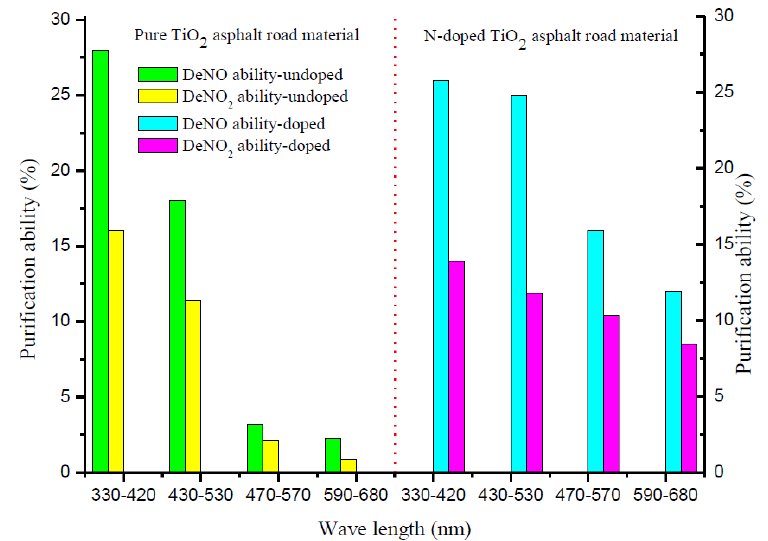
Figure 16. Degradation of NO and NO 2 on neat titania and N-doped titania coated asphalt under different irradiation conditions. (Reprinted/adapted with permission from Ref.